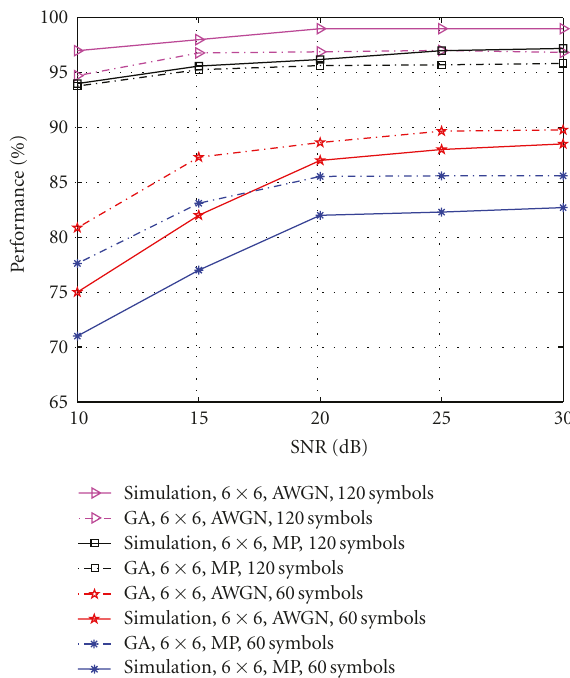
Figure 6: Simulation and Gaussian approximation results for estimating the size of a 6 × 6 block.